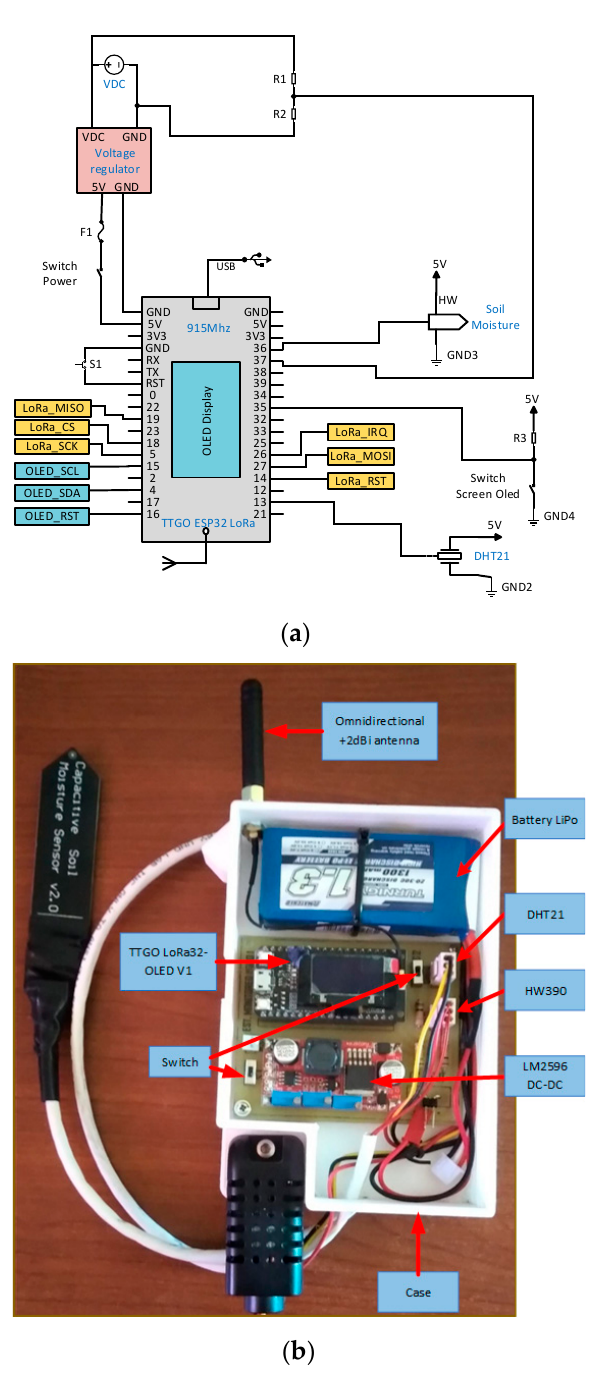
Figure 3. ( a ) Electronic schematic and ( b ) manufacture of transmitter node 1. For the synergy of the electronic components, a PCB board was designed, which is also protected by a customized IP65 internal protection grade housing 3D printed with PLA thermoplastic as shown in Figure 3b. Figure 4a shows the electronic diagram of the transmitter node 2; while Figure 4b shows the manufactured device. Unlike node 1; node 2 switches to the 3 Cell 1000 mAh LiPo TURNIGY battery at 11.1 V, which has an ML8511 analog sensor for UV radiation measurement under 5 V